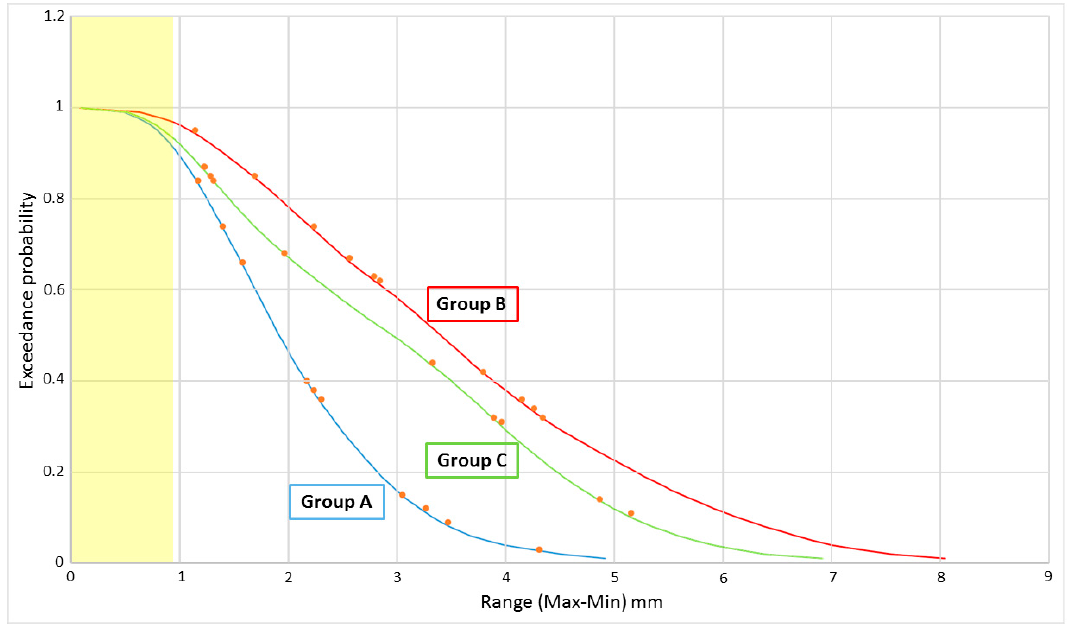
Figure 11. Exceedance plots for surge error ranges for Groups A, B, and C. Energies 2019 , 11 , x FOR PEER REVIEW 11 of 15 Table 4. Surge 𝑷 𝟓𝟓 values. The maximum values are the average of the peak surge values for the five repetitions in each group.